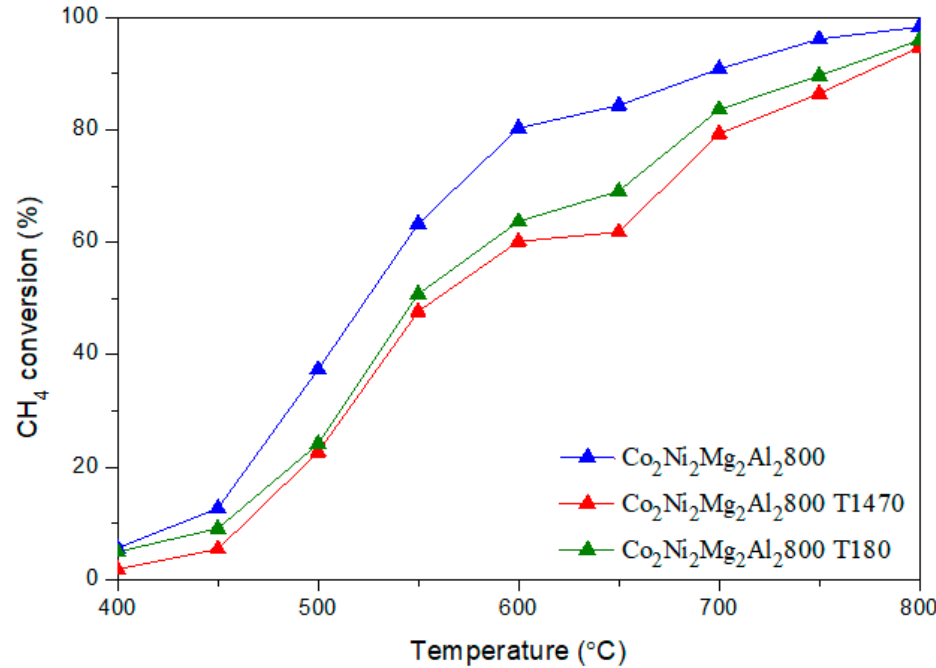
Figure 6. Evolution of the CH 4 conversion in DRM versus reaction temperature on the catalyst Co 2 Ni 2 Mg 2 Al 2 800 with and without toluene.